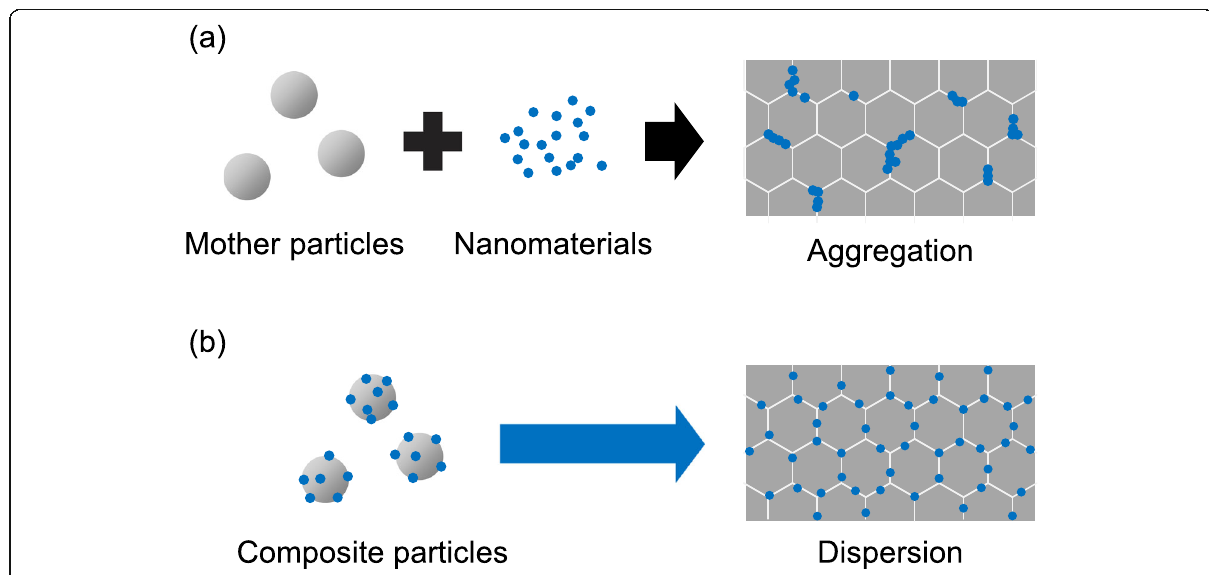
Fig. 1 Comparison of the microstructures obtained using a conventional mechanical milling method and b novel electrostatic adsorption technique for the fabrication of composite